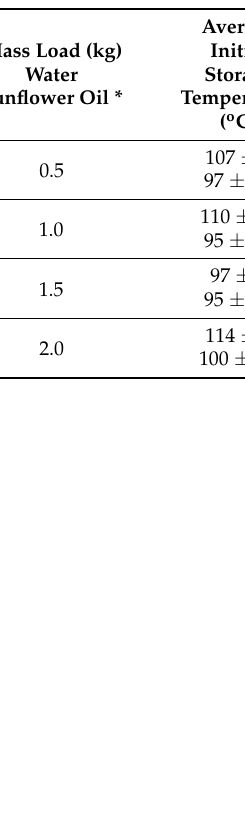
Table 4. Effect of the mass on the energetic and exergetic parameters for water and sunflower oil loads during discharging cycles with 2 mL/s.